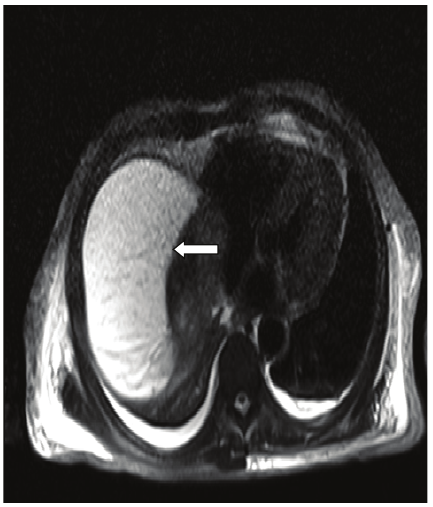
Figure 2: MRI of the abdomen with a large subcapsular abscess.